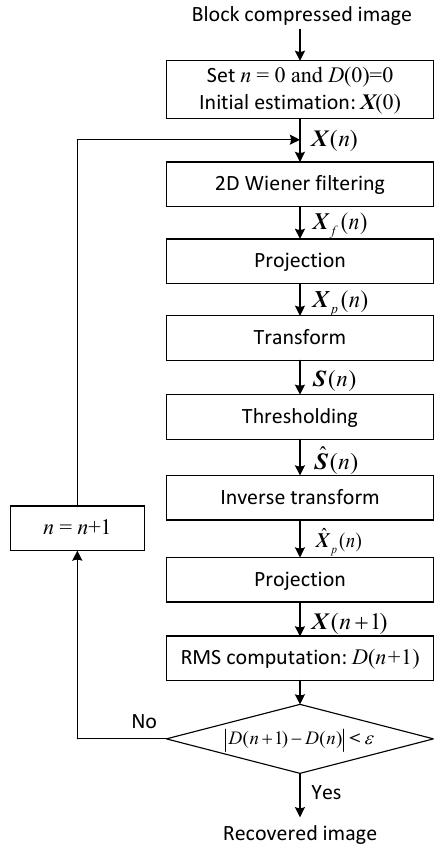
Figure 2. Image reconstruction using BCS-SPL